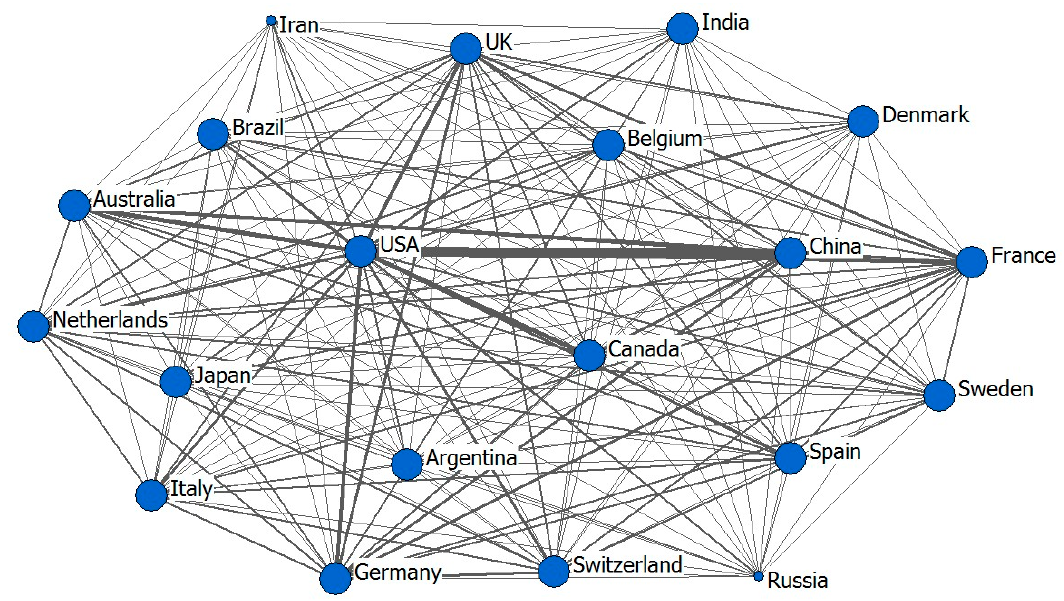
Figure 4. Core international collaboration network map of the top 20 countries from 1934 to 2019.